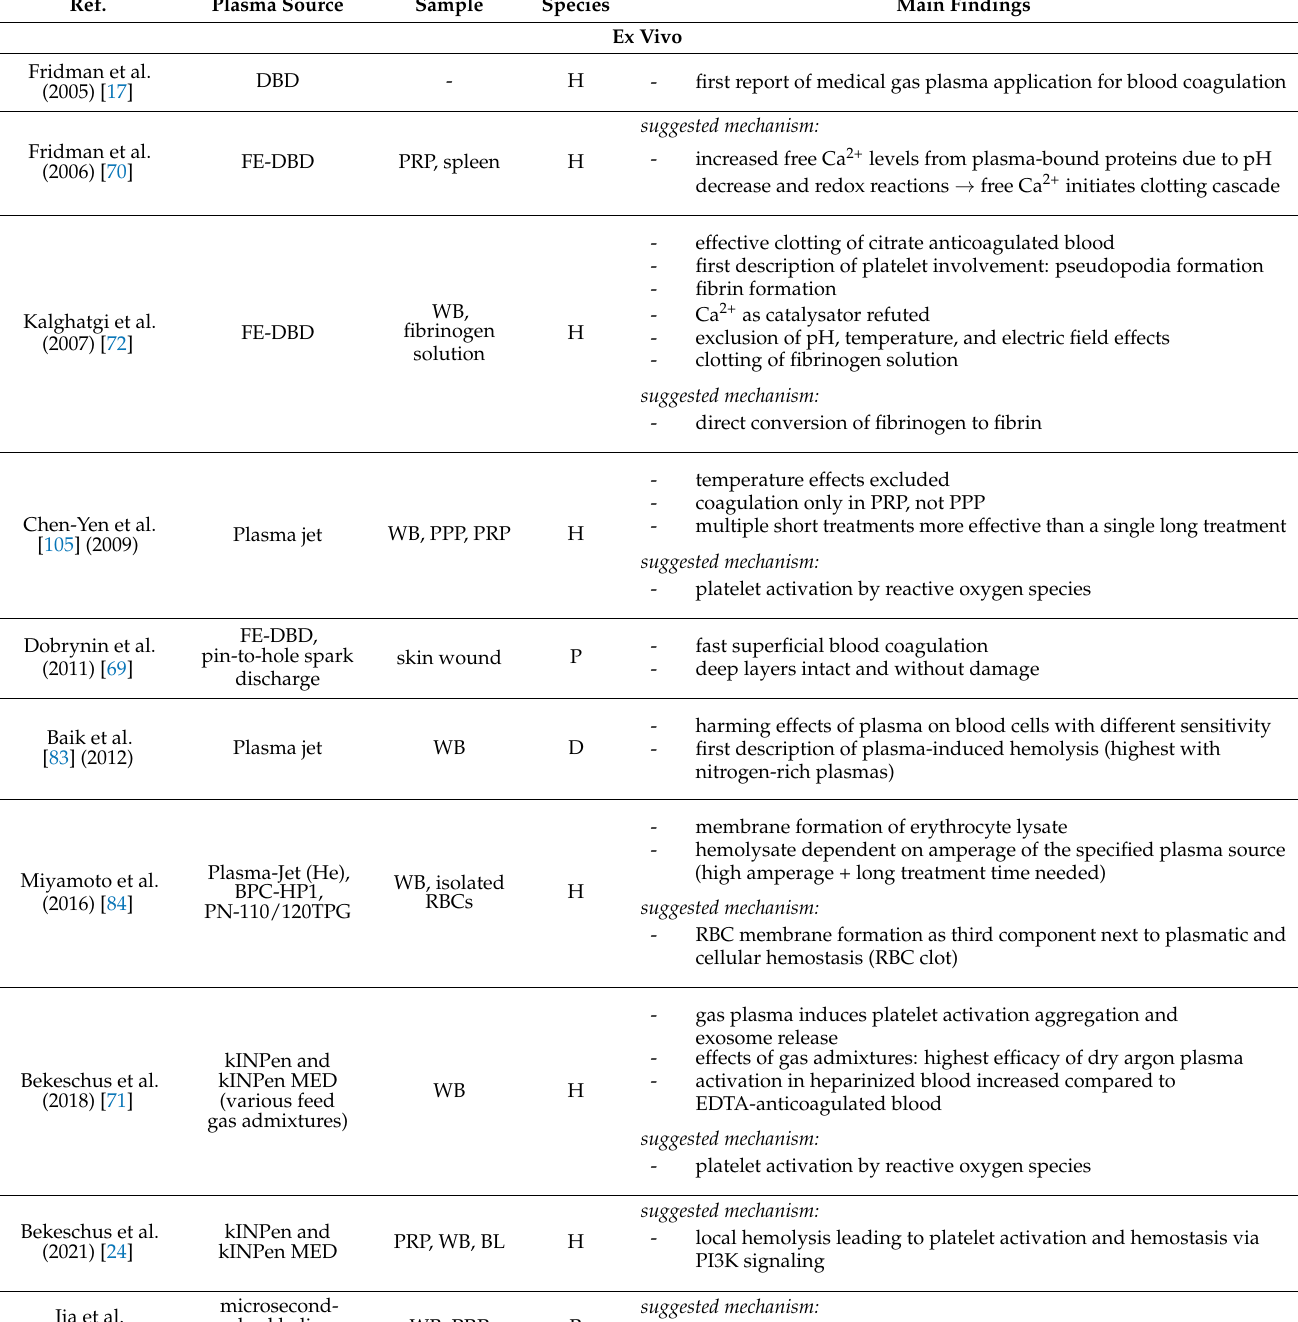
Table A1. Overview of blood coagulation studies using gas plasma technology, and main findings, sorted by date of appearance. H = human; P = porcine; M = murine; R = rat; Rb = rabbit; D = dog; PRP = platelet-rich blood plasma; PPP = platelet-poor blood